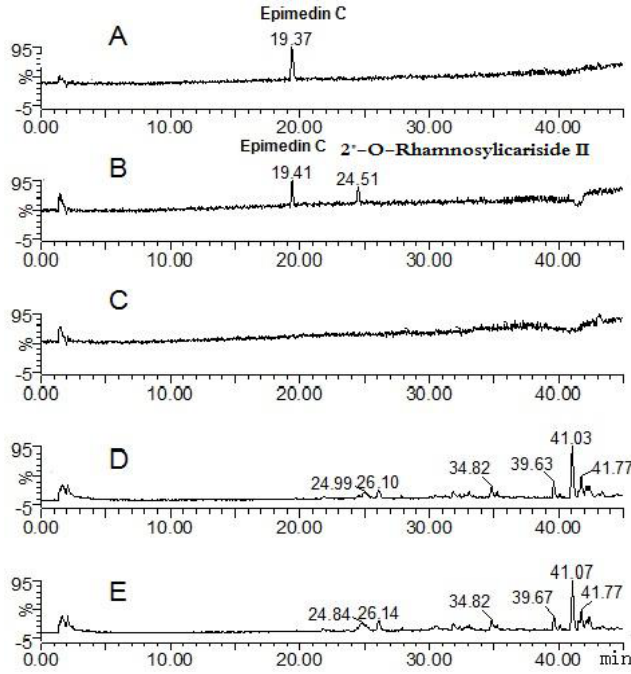
Figure 4. Mass spectrometry total ion current chromatograph for the epimedin C groups after 24 h (negative mode). A : epimedin C solution; B : epimedin C zebrafish solution; C : blank zebrafish group solution; D : zebrafish of epimedin C zebrafish group; E : zebrafish of blank zebrafish